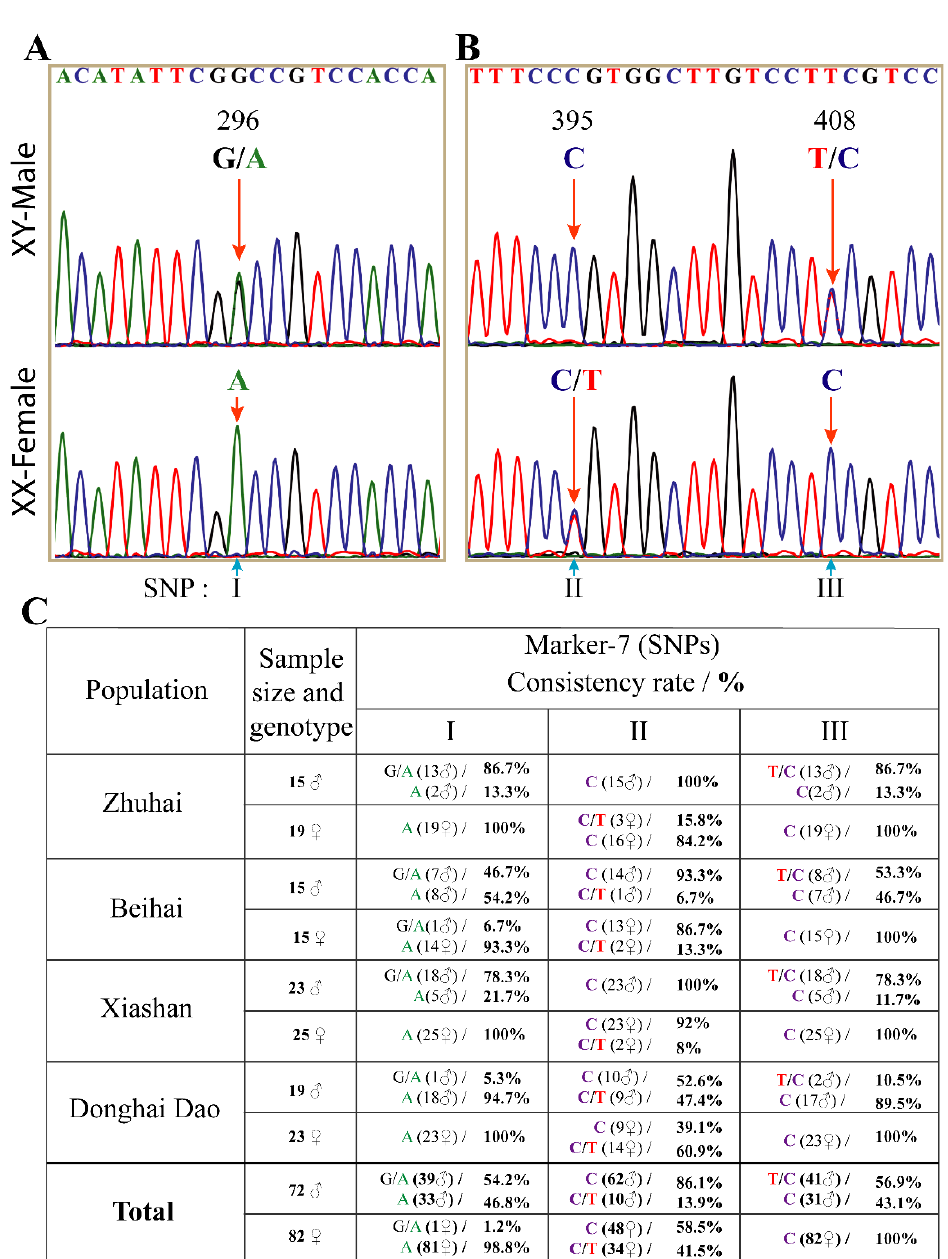
Figure 5. Three sex-linked SNPs in spotted scat Dmrt2a. SNPs in ( A ) exon2 (I) and ( B ) intron2, (II and III). ( C ) Consistency rates of the three SNPs with the genetic sex in different populations. Most males are heterozygous at I (G/A) and III (T/C) and homozygous at II ( C ), whereas females are homozygous at I ( A ) and III ( C ) and heterozygous at II (C/T).